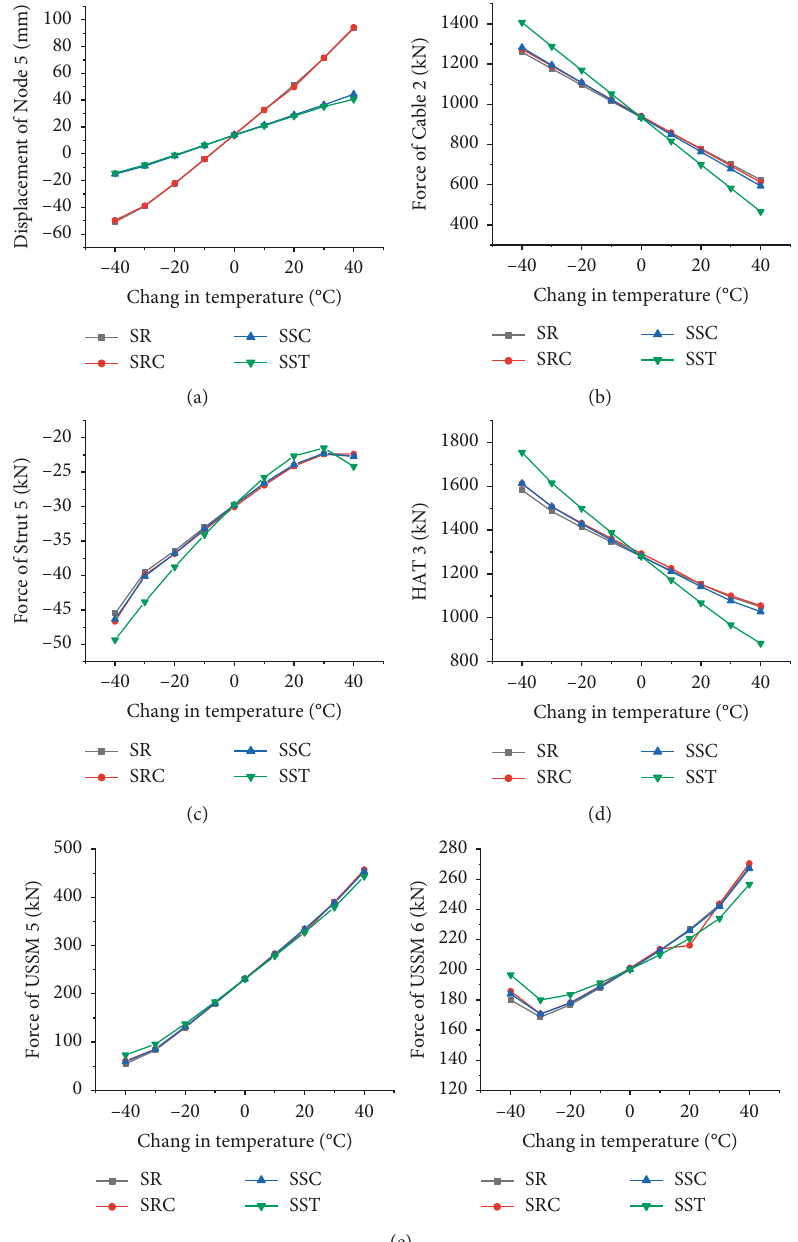
Figure 14: Changes in the maximum seismic response with varying temperature. (a) Change in the displacement of Node 5 with varying temperature. (b) Change in the cable force with varying temperature. (c) Change in the strut force with varying temperature. (d) Change in the horizontal arch thrust with varying temperature. (e) Change in the USSM force with varying